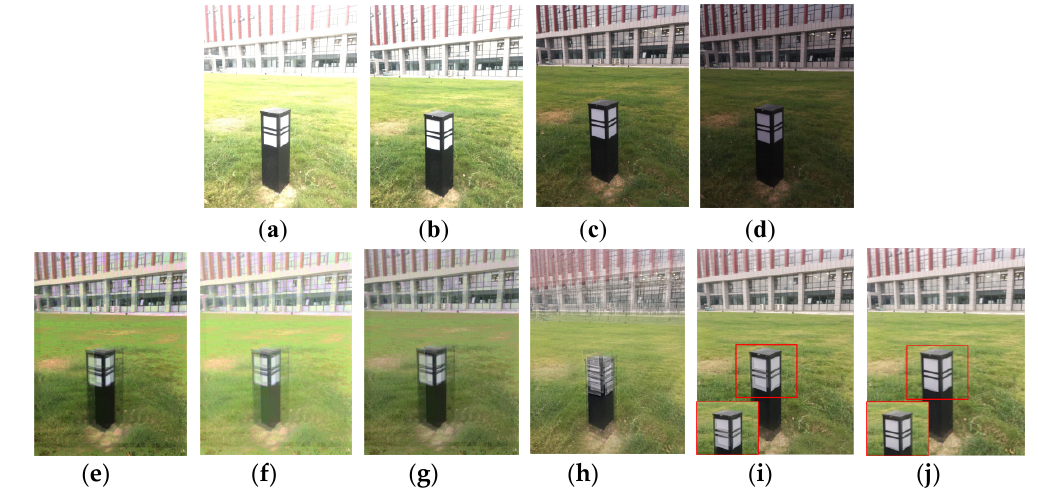
( b ) Figure 9. The comparison of image fusion results. ( a ) Fusion result of raw images; ( b ) Fusion result of JPEG images. 4.2.2. Comparison with Other Methods Multi-method fusion for multi-exposure images . In this section, the proposed algorithm is compared with other traditional methods on multi-exposure raw image sequences. In Figure 10a–d, a multi-exposure raw image sequence is shown, and the fusion results are shown in Figure 10e–j. In Figure 10e–g the fusion results of three tone mapping methods [25,26,28] are provided, and appear to have distinct ghosting. Figure 10h represents the traditional direct fusion result using JPEG image sequences as inputs, the performance is extremely poor. Figure 10i depicts the fusion result of JPEG